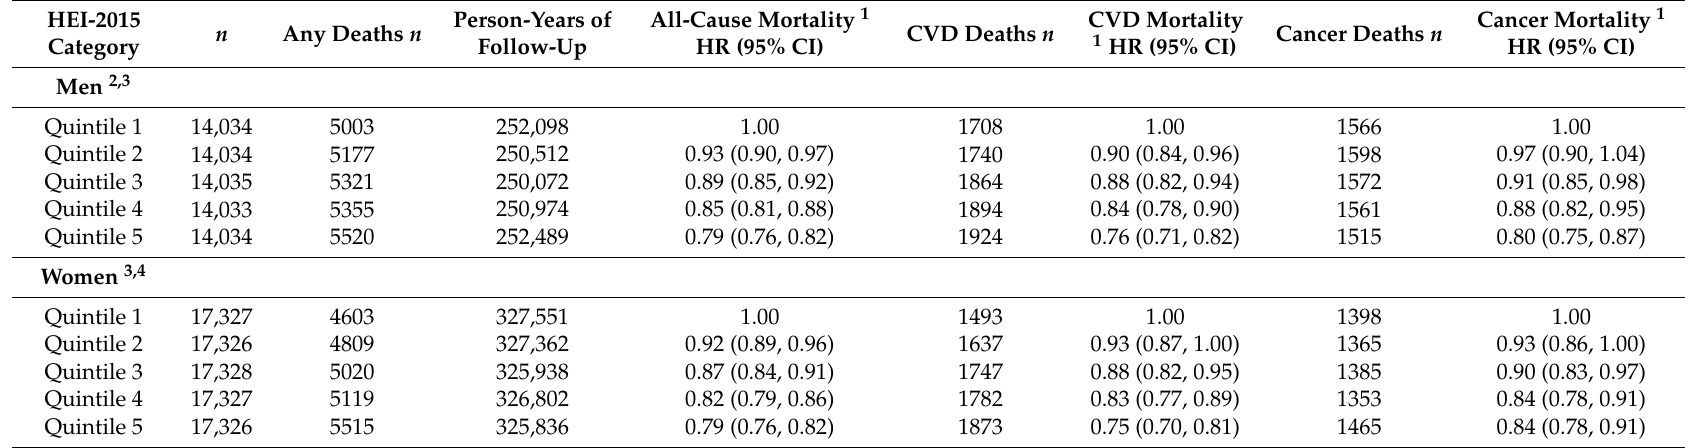
Table 3. Hazard ratios (HR) (95% confidence intervals (CI)) for all-cause, cardiovascular disease (CVD), and cancer mortality according to quintiles of Healthy